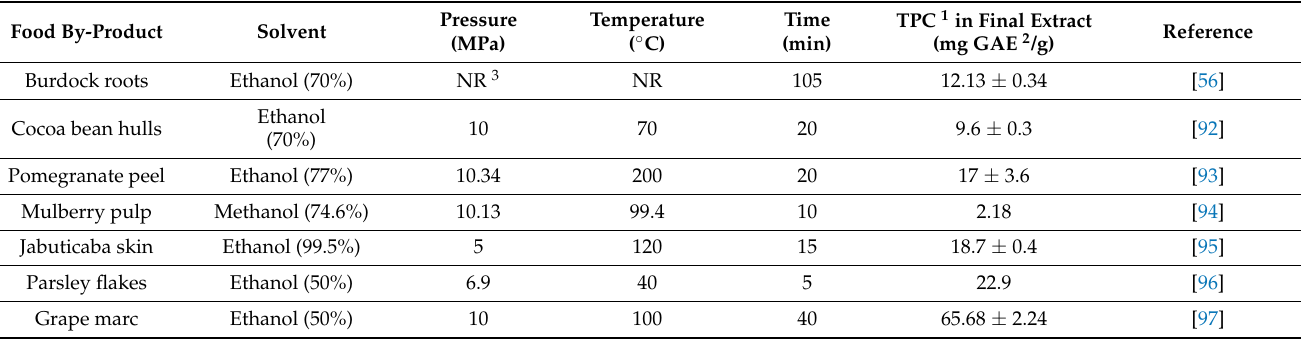
Figure 6. Simplified schematic of extraction of polyphenols using PLE. Table 3. Recovery of polyphenols from various food by-products using